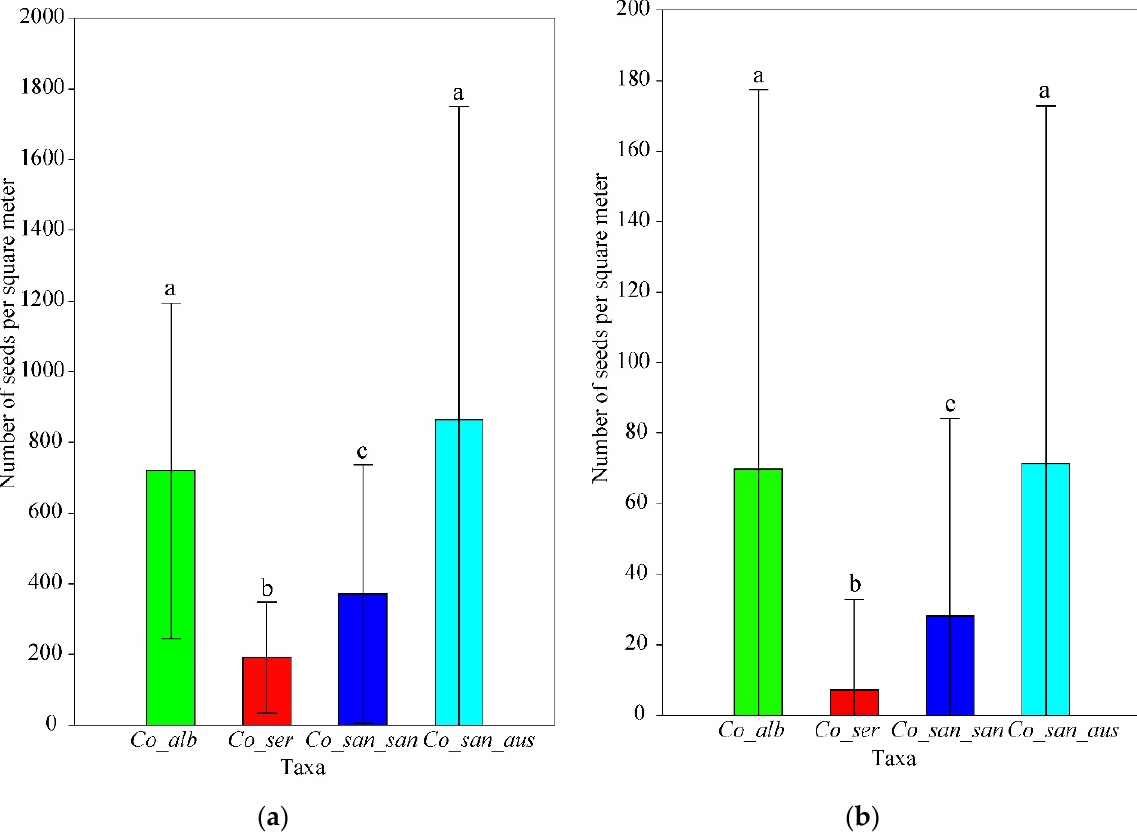
Figure 2. Mean number of the intact Cornus seeds per square metre: ( a )—upper layer (0–5 cm); ( b )—lower layer (5–10 cm). Whiskers indicate standard deviation. Different letters above the whiskers indicate significant differences ( p < 0.05) applying Dunn’s z -test. Abbreviations of taxa: